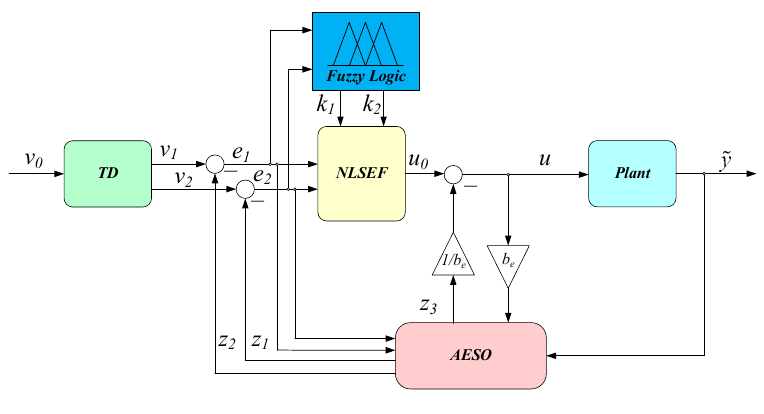
Figure 4. Structure of AFADRC.